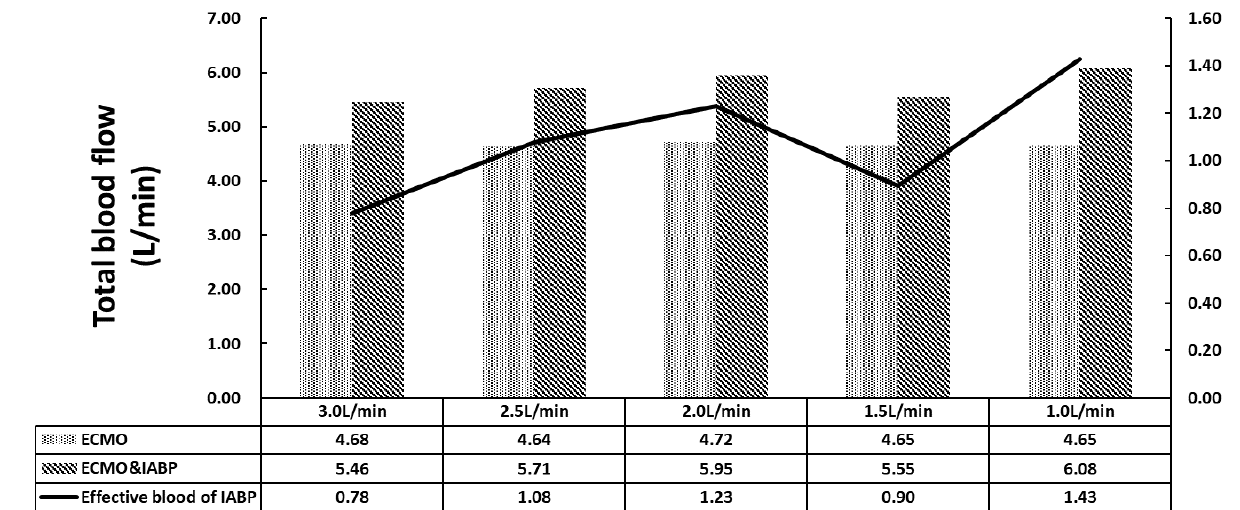
Figure 3. The total blood flow of coronary artery, brain, renal and lower limbs.